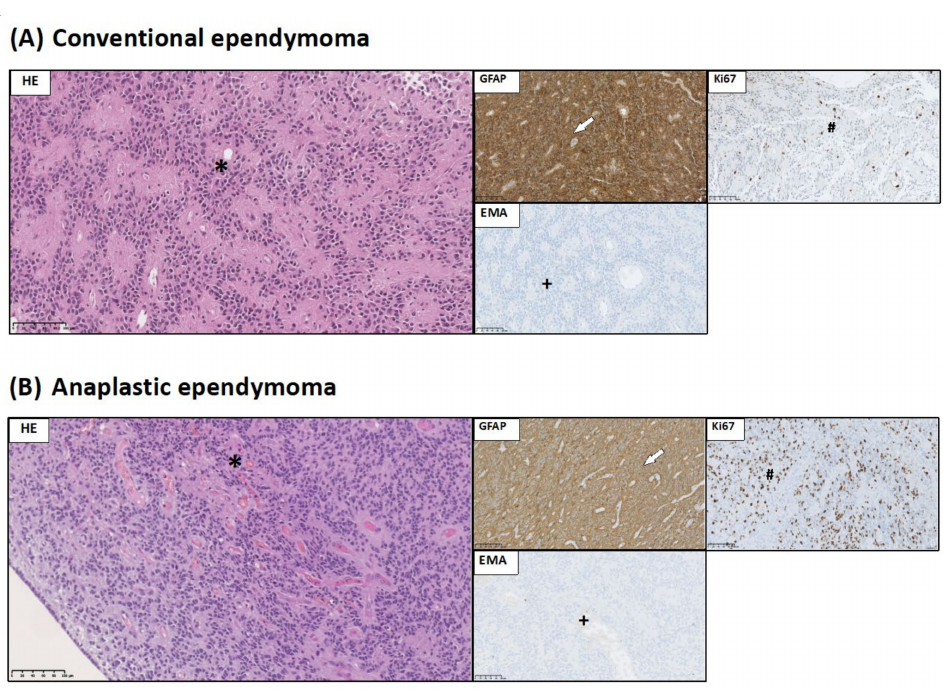
Figure 4. Histological and immunohistochemical staining of group 4 pediatric brain tumors: ependymoma and anaplastic ependymoma. HE staining as well as GFAP, Ki67, and EMA immunohistochemical staining were performed to visualize typical manifestations in these types of tumor tissue. ( A ) Ependymoma: pseudorosette structures (*). GFAP immunoreactiv- ity in neoplastic cells (white arrow). EMA dot-like reaction in tumor cells (+). Low Ki67 LI in tumor tissue (#). ( B ) Anaplastic ependymoma: pseudorosette structures and microvessel proliferation (*). GFAP immunoreactivity in neoplastic cells (white arrow). EMA reaction in single tumor cells (+). High Ki67 LI in tumor tissue (#). Preparations were scanned at original magnification 40 × , and digital magnification presented on image is 20 × for HE and 5 × for immunohistochemical